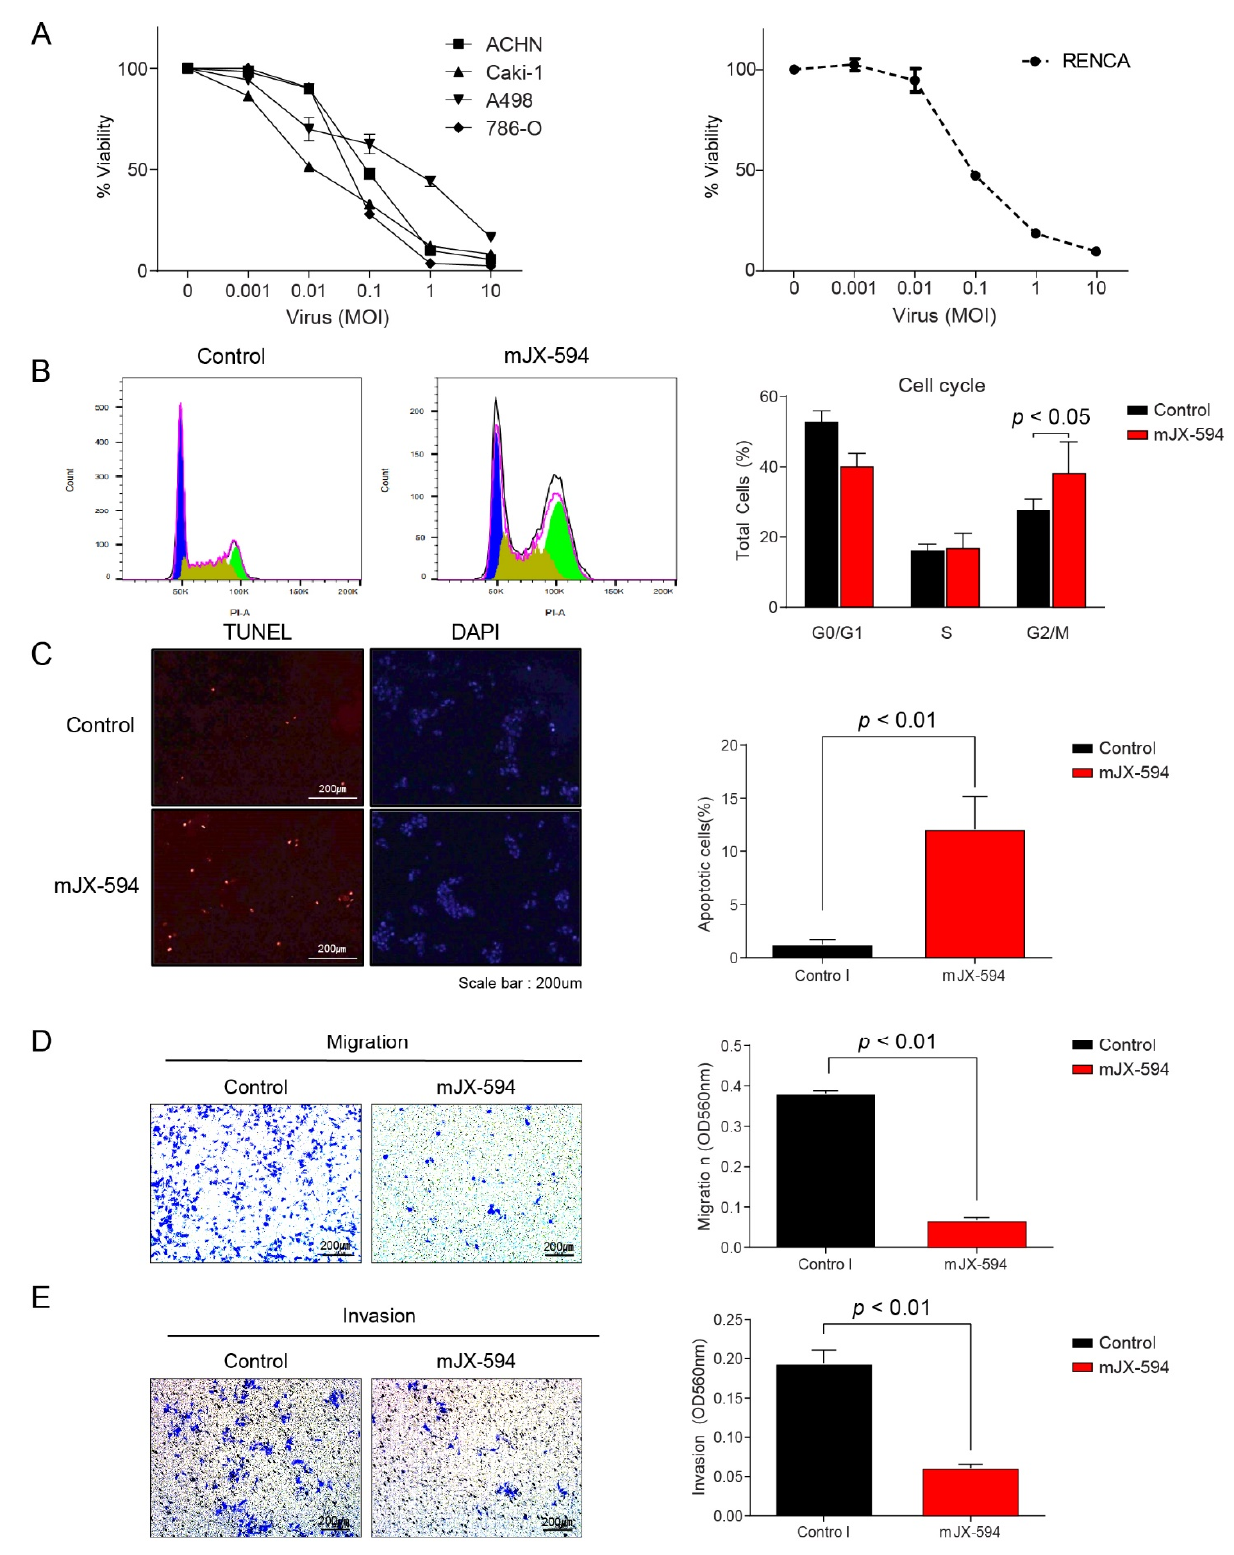
Figure 2. JX-594 has a direct oncolytic effect against human and murine renal cell carcinoma (RCC). ( A ) Cell viability of human (786-O, A498, ACHN, Caki-1) and murine (Renca) RCC cell lines treated with escalating doses of JX-594 or mJX-594. ( B ) Cell cycle analyses of mJX-594-treated cells. Renca cells treated with mJX-594 (1 MOI) were analyzed by flow cytometry for DNA content at 24 h post-